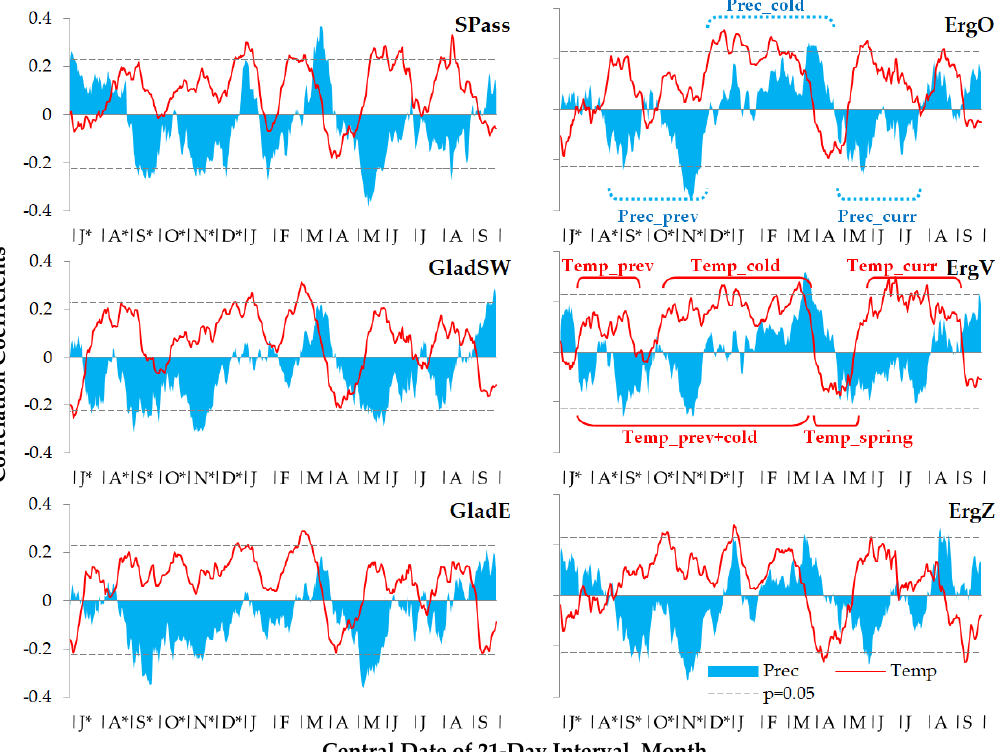
Figure 2. Climatic response of P. sibirica radial growth: correlations of residual TRW chronologies SPass, GladSW, GladE, ErgO, ErgV, and ErgZ with 21 day moving series of temperature (Temp, red line) and precipitation (Prec, blue area) over the 1936–2010 period. Asterisks (*) mark months of the previous year; dashed horizontal lines mark the significance level p = 0.05. Brackets mark seasons of unidirectional responses ( prev , previous vegetation season; cold , cold season; spring , early spring season; curr , current vegetation season).